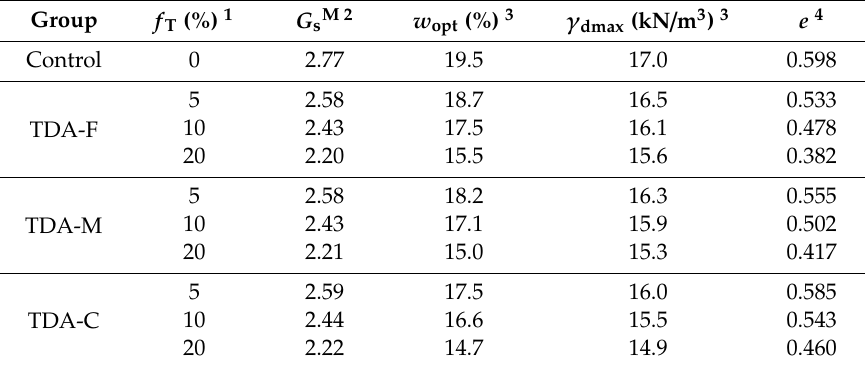
Table 3. Soil–TDA mix designs and their